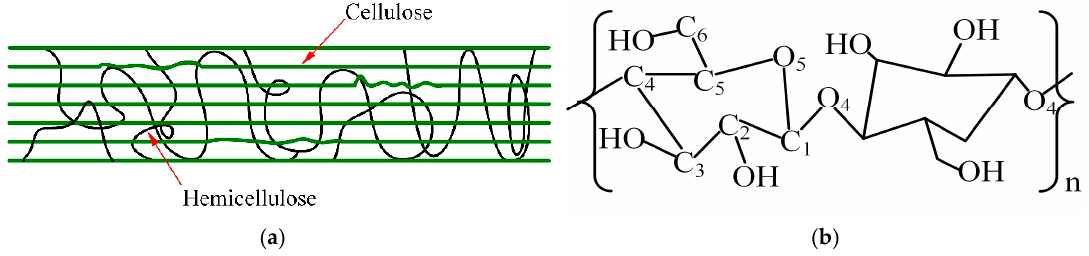
Figure 7. Schematic diagram of the pressboard microstructure: ( a ) The arrangement of cellulose and hemicellulose within the pressboard; ( b ) The chemical structure of cellulose glucose monomer.